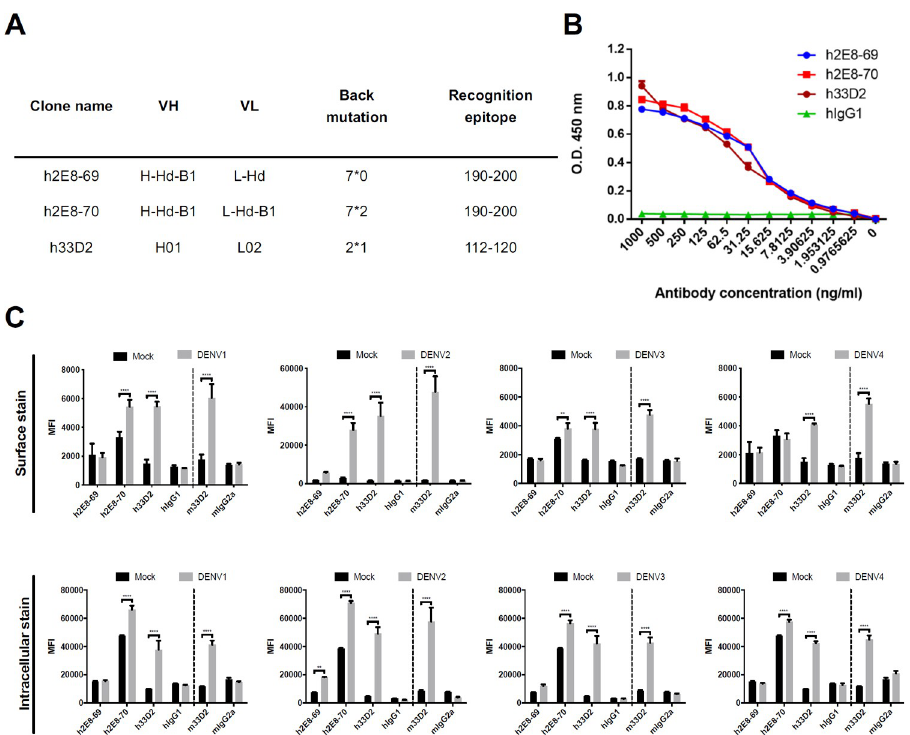
Fig 1. Comparison and characterization of three humanized mAb candidates. ( A ) The details of h2E8-69, h2E8-70 and h33D2 are shown. The numbers of back mutation of each humanized mAb are shown as heavy chain mutation number � light chain mutation number. ( B ) The binding activity of each humanized mAb including h2E8-69, h2E8-70, h33D2 and isotype control hIgG1 to full length NS1 was determined by ELISA. ( C ) The binding ability of h2E8-69, h2E8-70, h33D2, isotype control hIgG1, mouse 33D2 (m33D2), and isotype control mouse IgG2a (mIgG2a) to DENV- infected cells were analyzed by flow cytometery. Huh7 cells were infected by four different DENV serotypes (MOI = 2: DENV2 and DENV4; MOI = 5: DENV1 and DENV3) for 48 h. Non-fixed (upper panel) and paraformaldehyde-fixed (lowed panel) Huh7 cells were incubated with mouse anti-NS1 mAb m33D2, humanized anti-NS1 mAbs h33D2, h2E8-69, h2E8-70 as well as mouse isotype control IgG2a or human isotype control IgG1, followed by FITC- conjucated anti-mouse/human IgG and analyzed by flow cytometry. All data are presented as the averages of triplicate cultures ± S.D. �� : p < 0.01, ���� : p < 0.0001. Statistical significance was based on two-way ANOVA. MFI: mean fluorescence